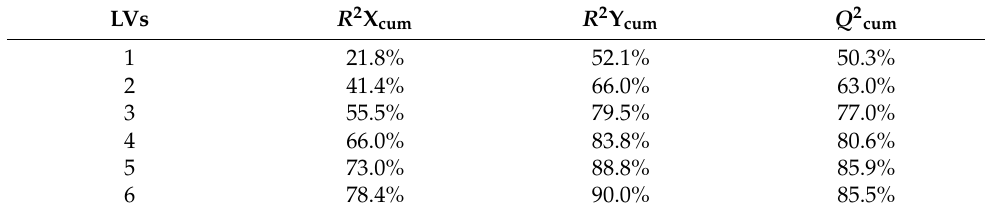
Table 5. Diagnostics of the partial least squares regression model. LVs R 2 X cum R 2 Y cum Q 2 cum 1 21.8% 52.1% 50.3% 41.4%